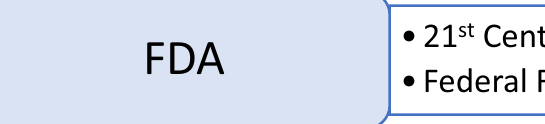
FDA Food and Drug